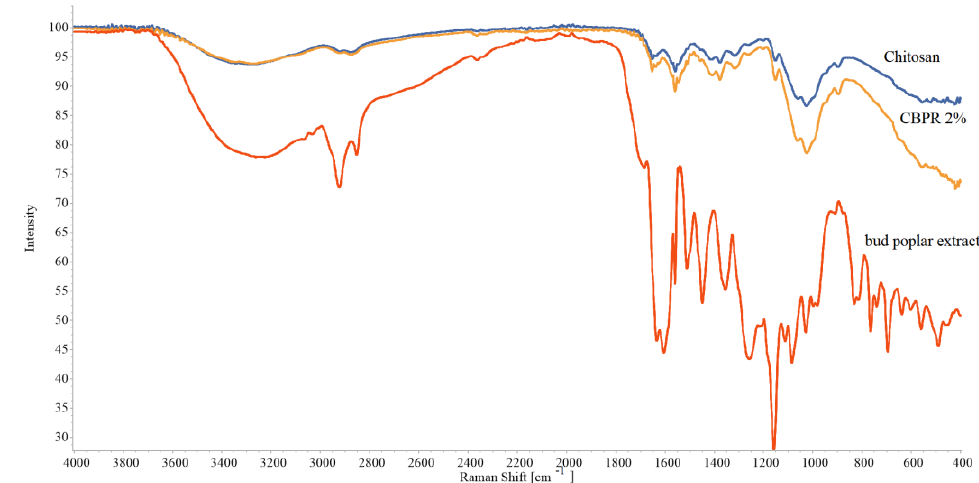
Figure 2. ATR-FT IR spectra of chitosan film, CBPR 2%, and bud poplar extract. Figure 2 . ATR ‒ FT IR spectra of chitosan film, CBPR 2%, and bud poplar extract.